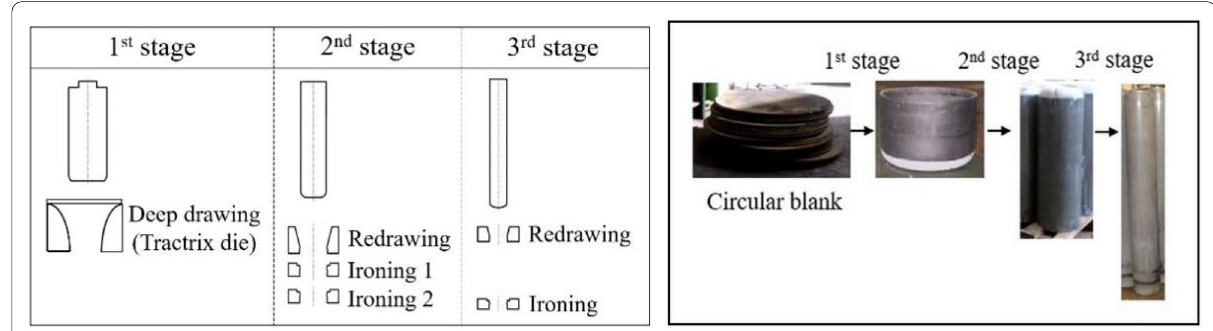
Figure 1 DDI process for manufacturing CNG pressure vessel